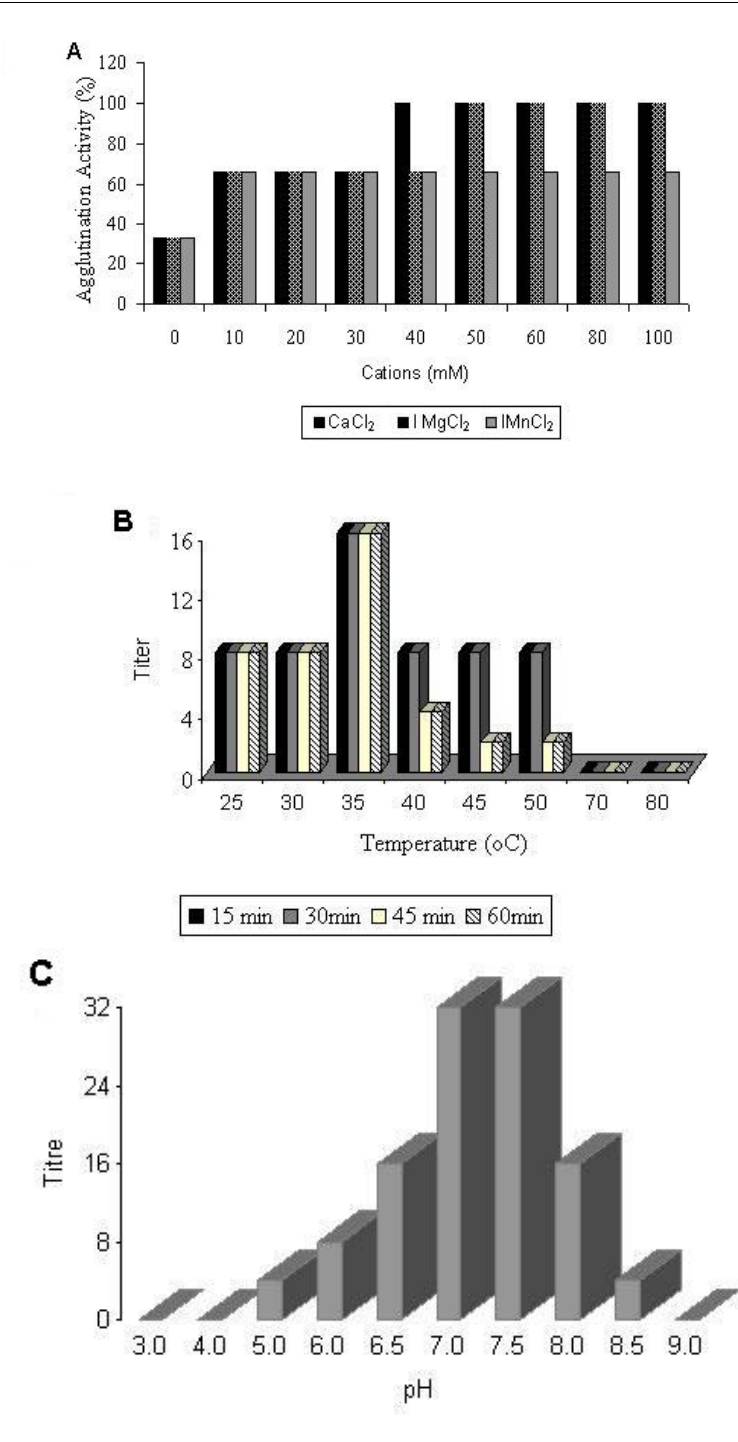
Figure 2. Effect of divalent cations (A), temperature (B) and pH (C) on Bothrops jararacussu lectin hemagglutinating activity. Thermal stability was verified by maintaining the lectin solution at different temperatures for increasing exposure times. The effect of pH was measured by incubating the lectin solution with different pH-buffered solutions for 1h at 25°C. All procedures were followed by activity assays under standard